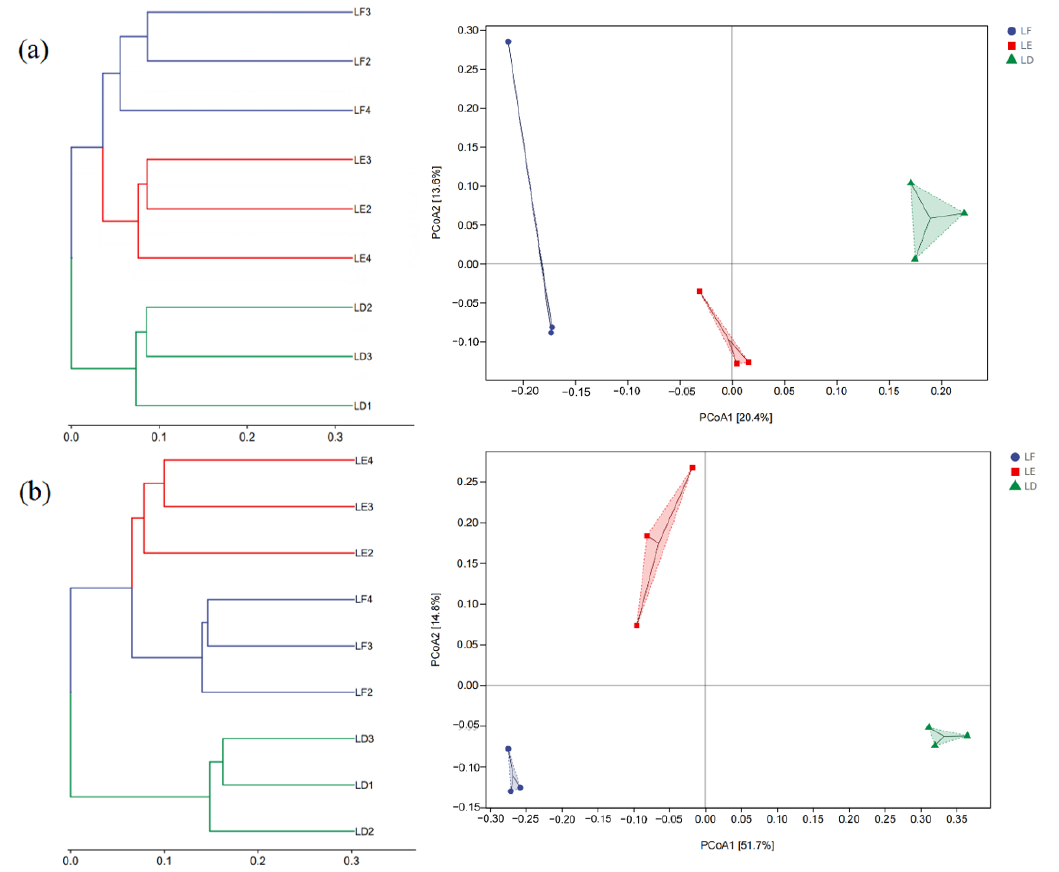
Figure 6. Principal coordinate analysis and hierarchical clustering analysis of soil bacterial and fungal community composition in different treatments. ( a ): soil bacterial communities; ( b ): soil fungal communities. LF: Morus alba ; LD: Arachis hypogaea ; LE: Morus alba - Arachis hypogaea.